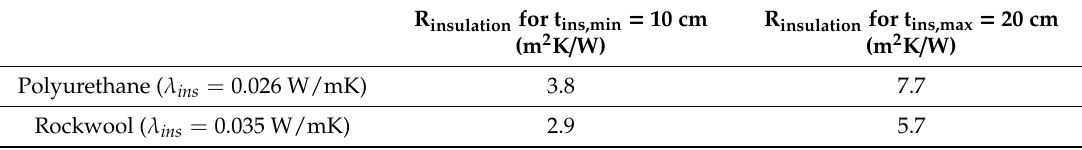
Table A1. Variability of the insulation resistance as a function of thickness and material type. R insulation for t ins,min = 10 cm R insulation for t ins,max = 20 cm (m 2 K / W) (m 2 K / W) Polyurethane ( λ ins = 0.026 W/mK)